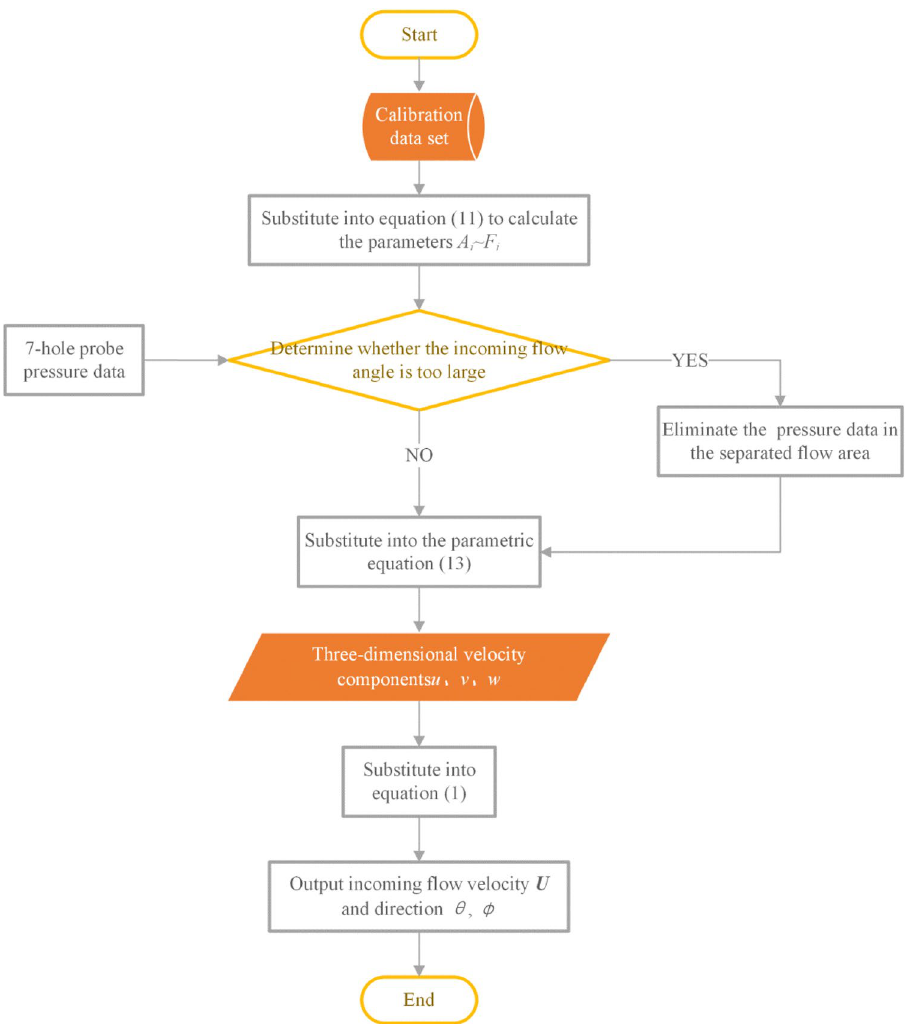
Figure 7. Flow chart of probe calibration